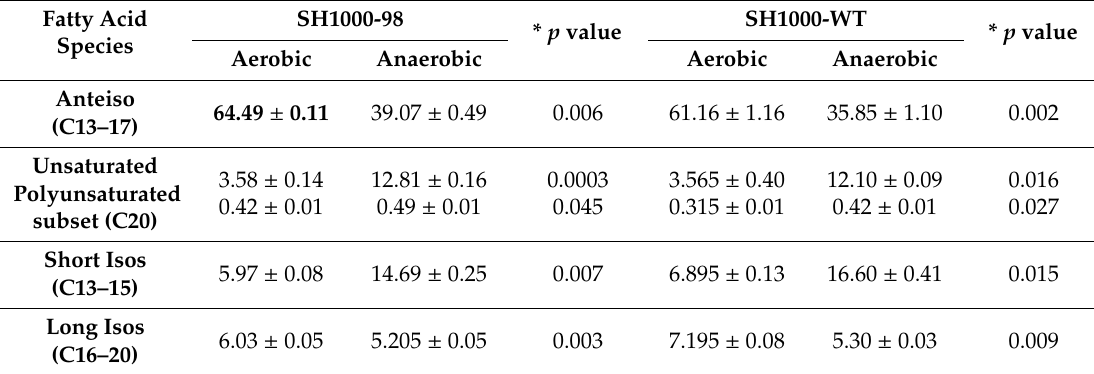
Table 2. Summary fatty acid compositional di ff erences between parent and snoD mutant.